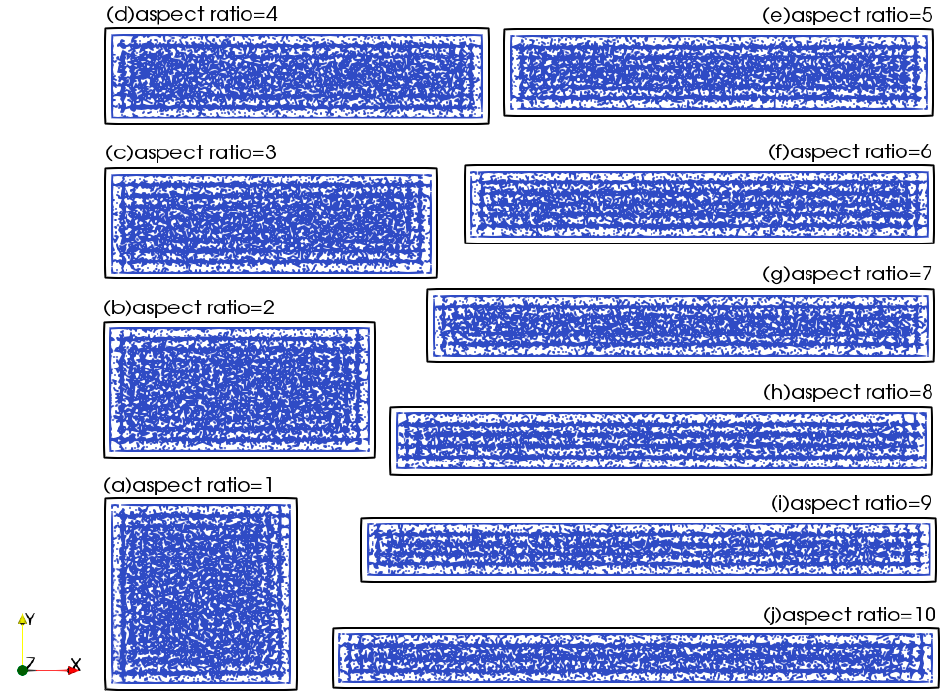
Figure 9. Pebble center distribution in the x - y planes of the rectangular pebble beds with a fixed cross-sectional area of 225 d 2 and various aspect ratios of ( a ) 1, ( b ) 2, ( c ) 3, ( d ) 4, ( e ) 5, ( f ) 6, ( g ) 7, ( h ) 8, ( i ) 9, ( j ) 10 (Color online).